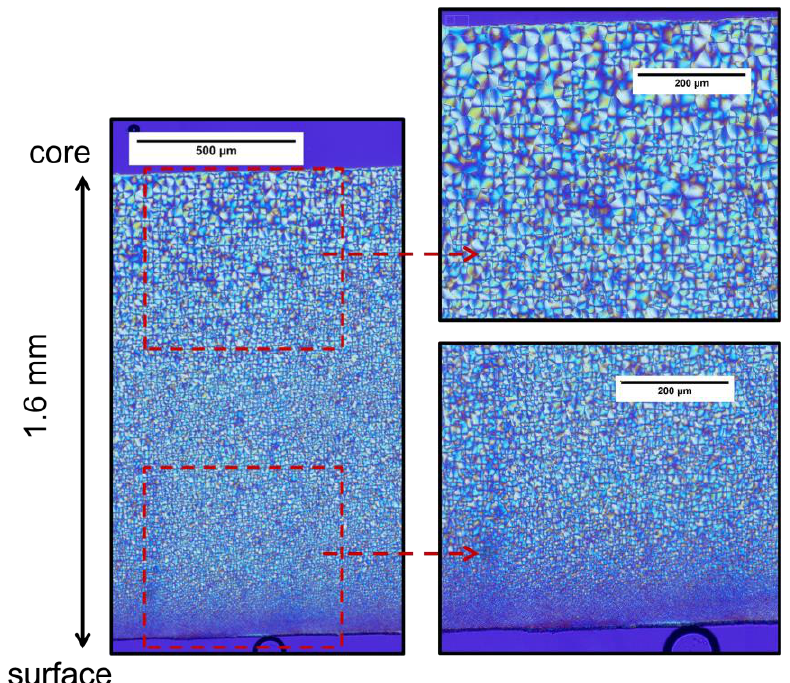
Figure 5. Polarized light microscopy observation of the spherulites for a 140 °C 168 h aged PA66. The picture on the left depicts half of the thickness of the plaque.